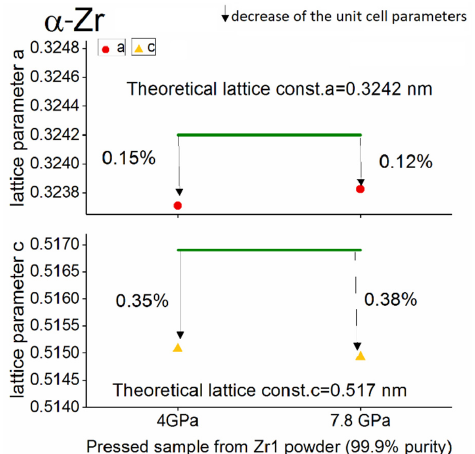
Figure 4. The change of the lattice parameters (in %) for the α -Zr phase in the pressed sample compacted from high purity powder—Zr 1 (99.9%).